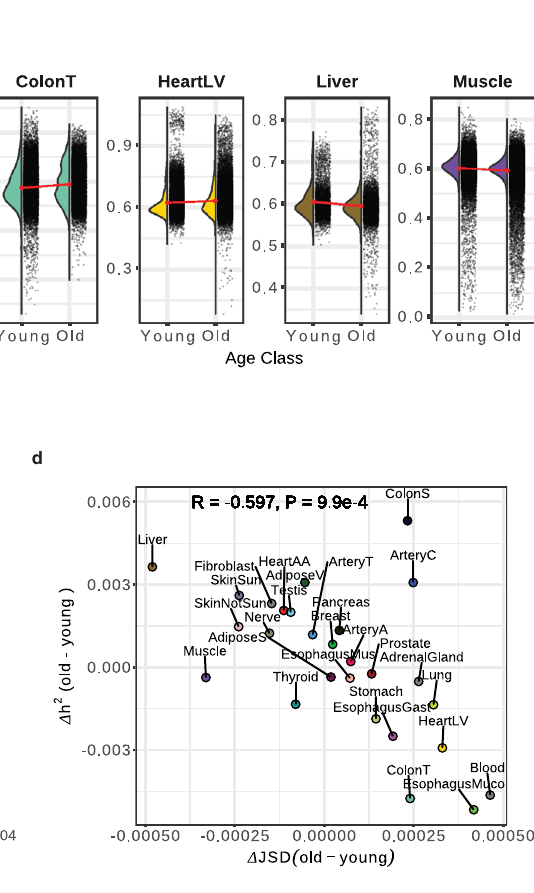
Fig. 2 | Inter-individual gene expression heterogeneity changes with age for a subset of tissues. a Hypothesized age-associated changes in gene expression heterogeneity (top) and our approach for quantifying the inter-individual expres- sion distance with age using the Jensen Shannon Divergence metric (JSD) for age- binned individuals (bottom). b The distributions of JSD distances for four example tissues in old and young bins. Red points show the means for each group. Cloud plots show individual pairwise distances and half violin plots show distributions.